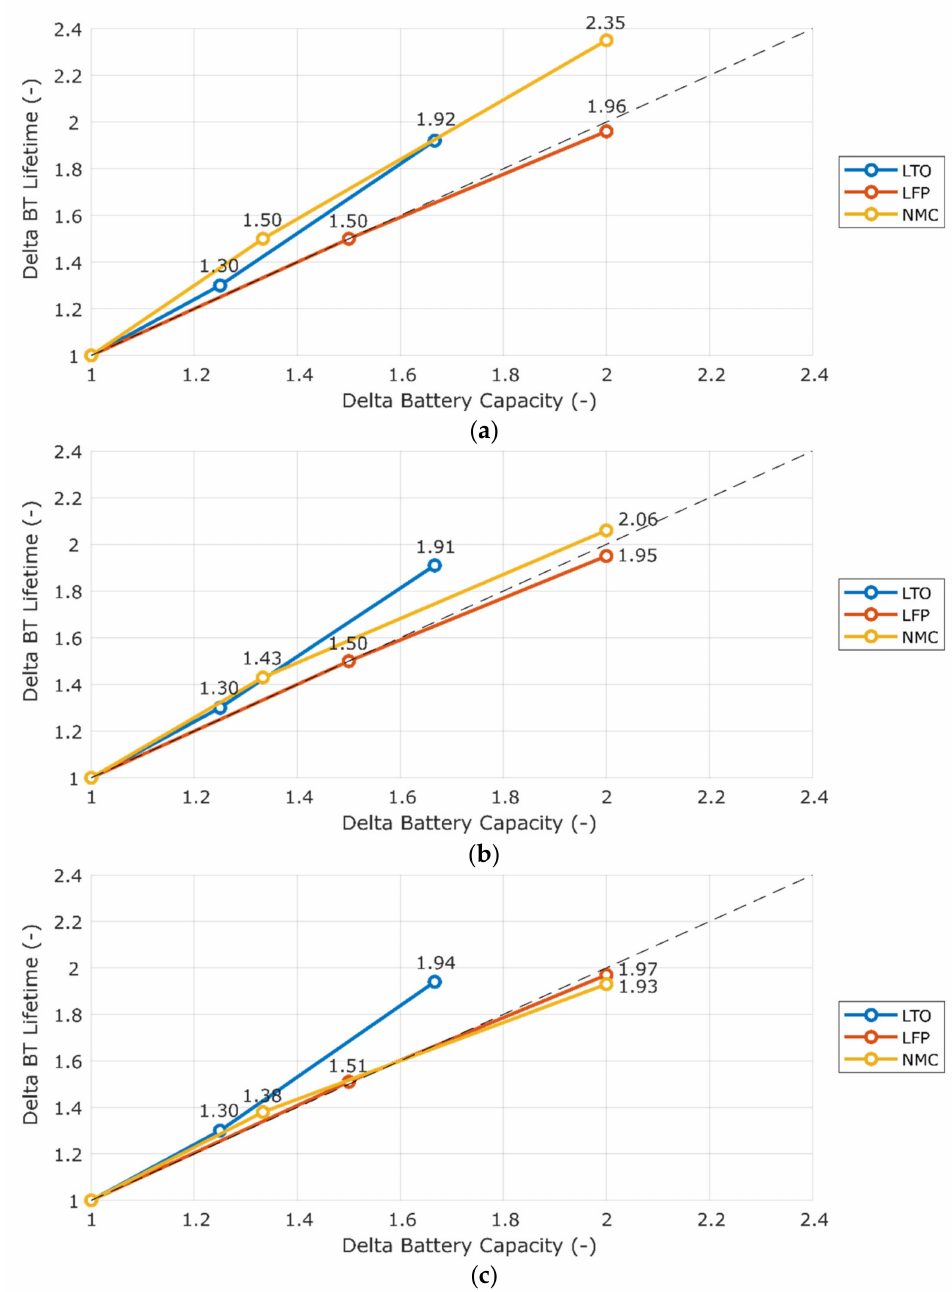
Figure 12. BT life increase/decrease in relation to battery capacity increase/decrease. Dotted lines represent cost-efficiency borderline. ( a ) Barcelona bus line. ( b ) Osnabrück bus line. ( c ) Gothenburg bus